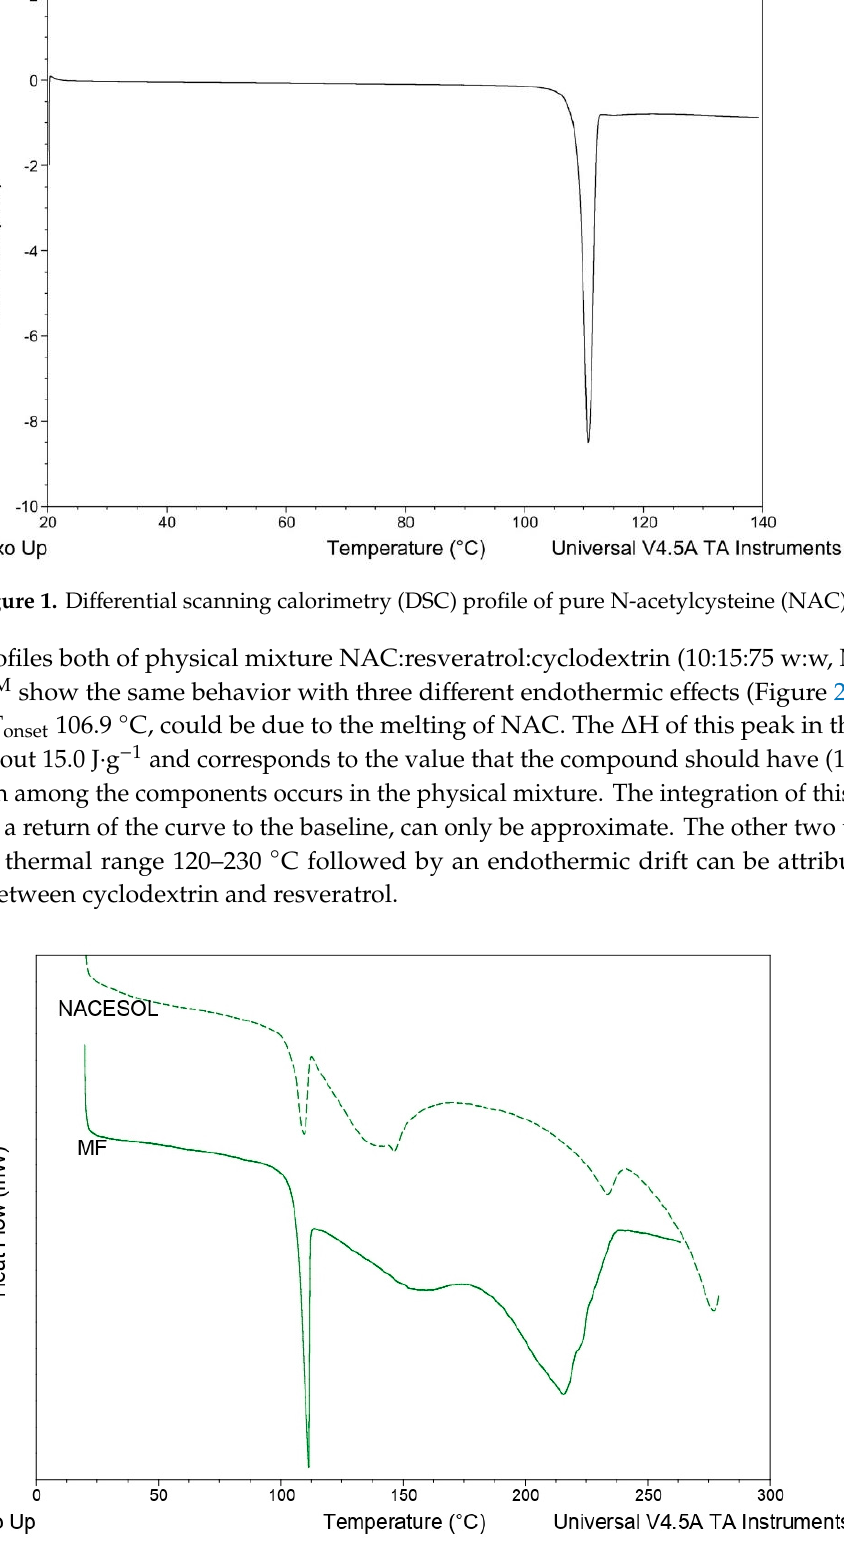
Figure 2. DSC profiles of NACESOL TM and physical mixture (MF) NAC:Resveratrol:cyclodextrin (10:15:75 w:w:w).